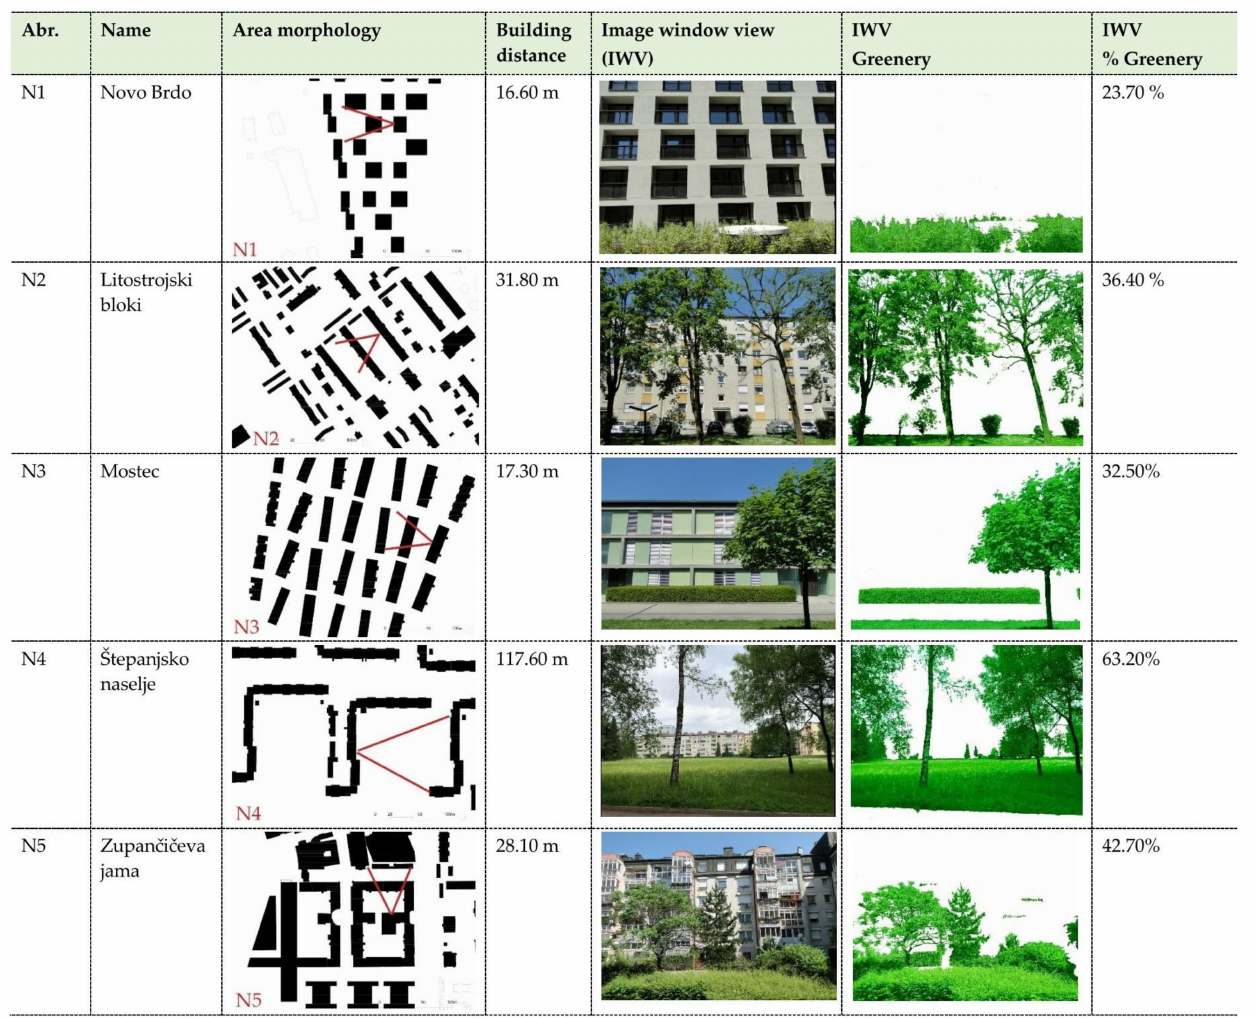
Figure 2. Five window views of residential neighborhoods. On the morphological scheme (area morphology) is marked the viewing angle of the window view (horizontal viewing field of the eye with 70 ◦ angle of word pattern recognition). Research on the greenery in the window view was done in parallel with the